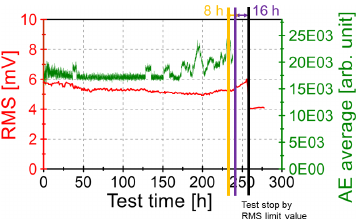
Figure 9. Comparison of vibration and AE signal over the test time. Arb. unit: arbitrary